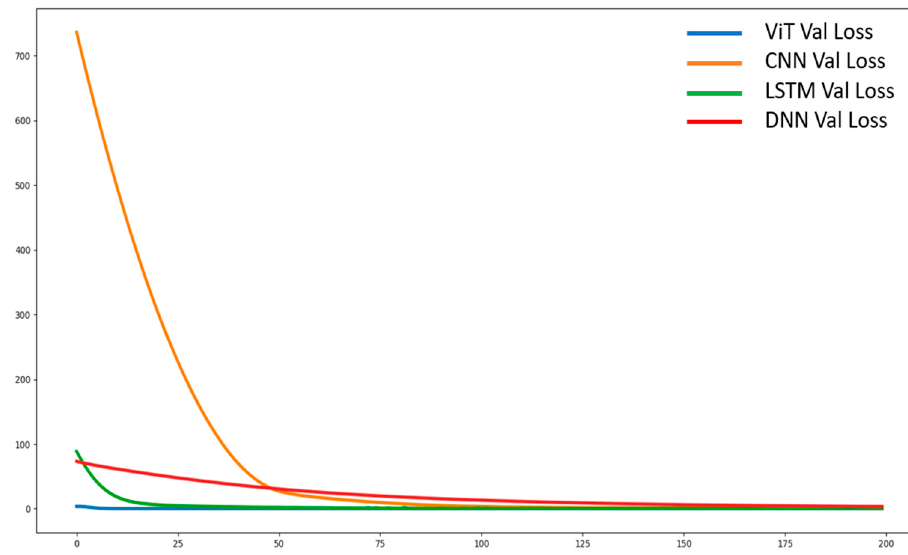
Figure 9. Loss of the validation datasets.